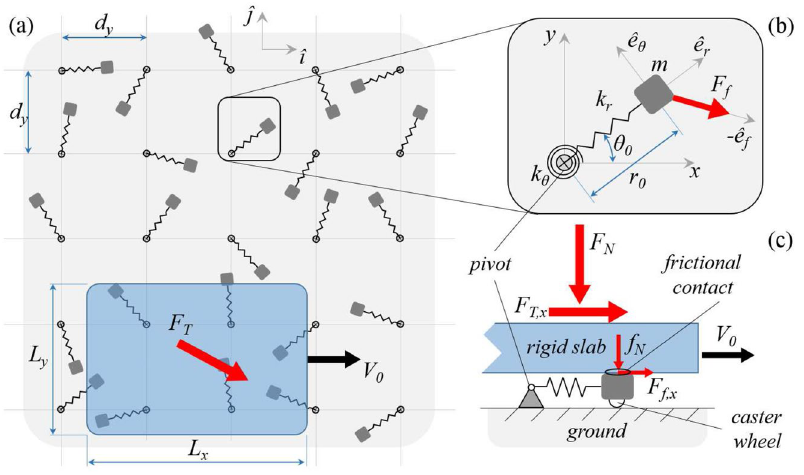
Figure 2. The functional scheme of the system at hand: a rigid sliding slab is borne by an array of in-plane elastic supports. ( a ) is a top view of the whole system; whereas ( b ) is a close-up to a generic support of mass m , radial and torsional stiffness k r and k θ , static length r 0 and static orientation θ 0 . ( c ) is a side view of the